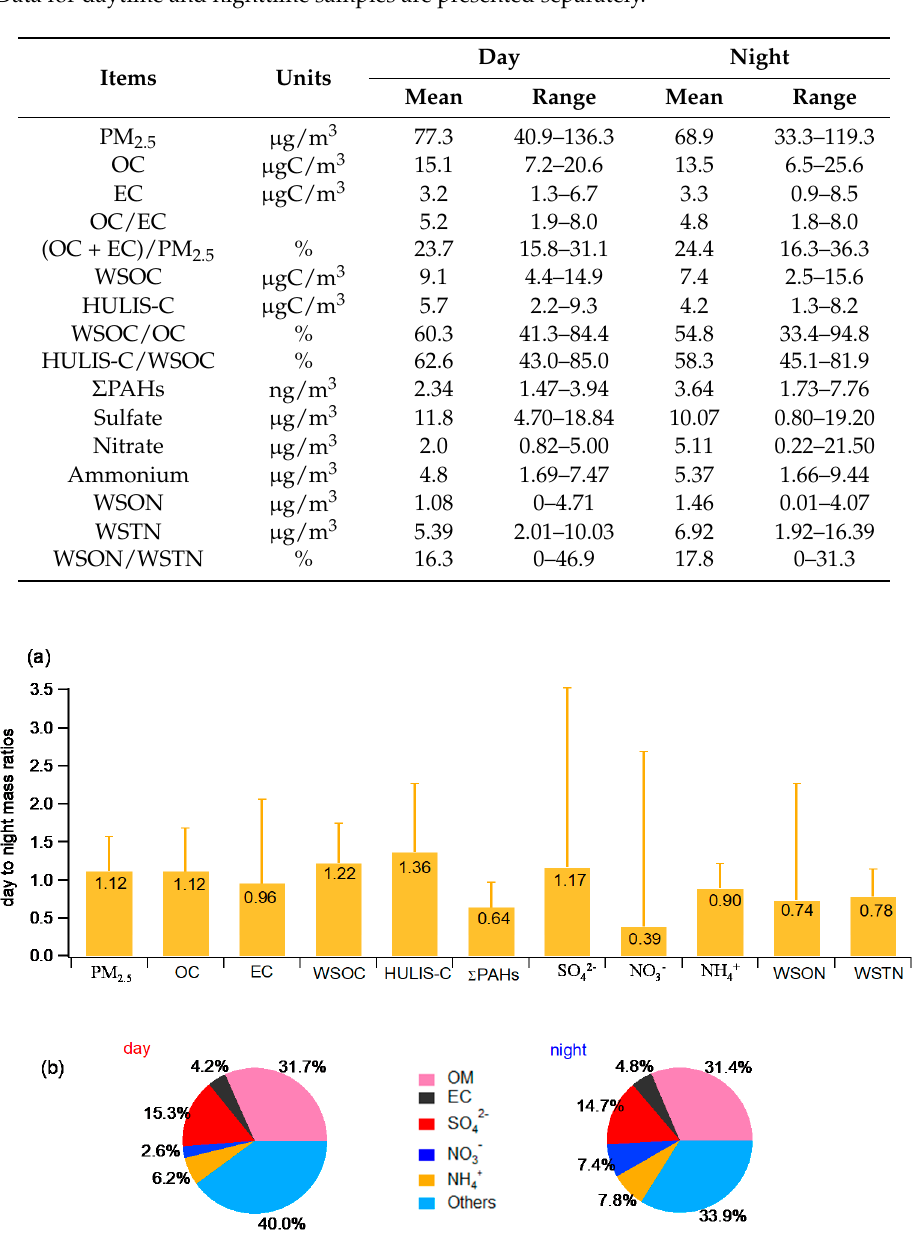
Figure 1. ( a ) Day to night mass ratios of selected chemical species in PM 2.5 ; ( b ) average chemical compositions of PM 2.5 collected during daytime and nighttime, respectively. Error bar represents the standard deviation.